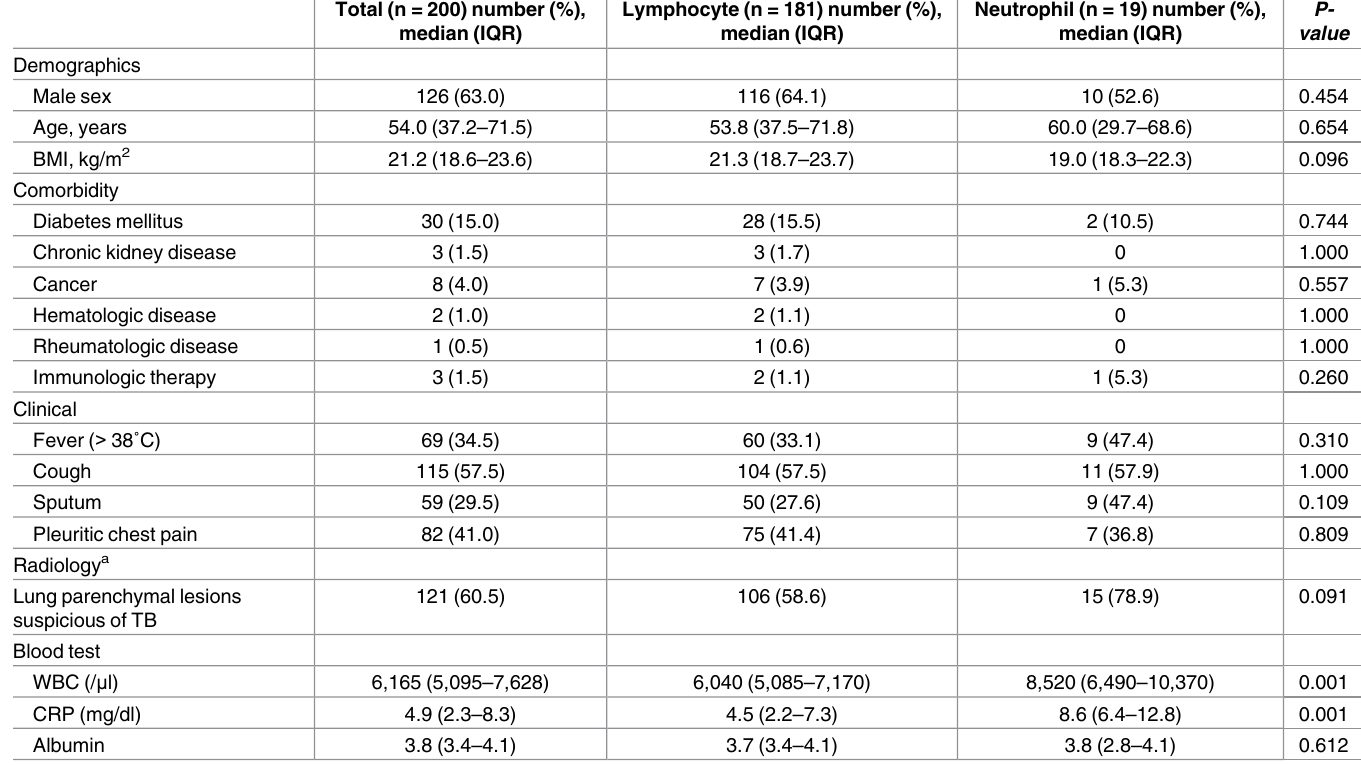
Table 1. Baseline Characteristics of 200 Patients with Pleural TB.